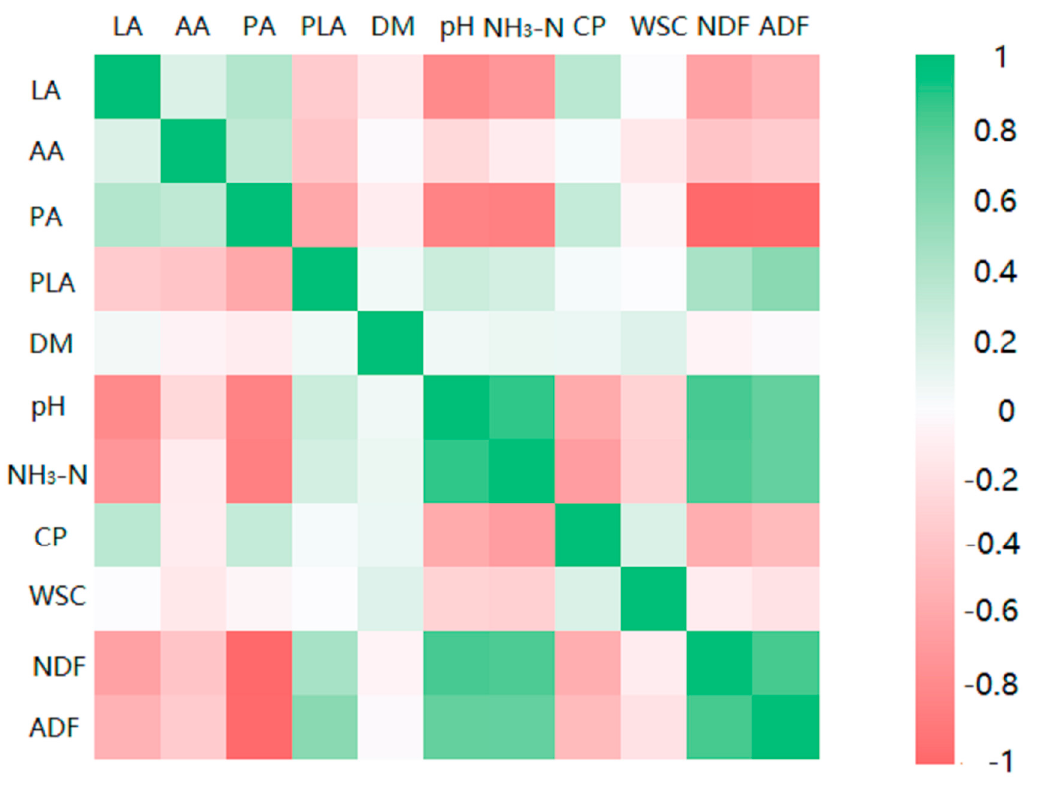
Figure 3. Spearman correlation between the fermentation indices in alfalfa silage after 45 days of ensiling. LA, lactic acid; AA, acetic acid; PA, propionic acid; PLA, phenyllactic acid; DM, dry matter; NH3–N, ammonia nitrogen; CP, crude protein; WSC, water soluble carbonhydrate; NDF, neutral detergent fibre; ADF, acid detergent fibre. The color means the significant correlation ( p < 0.05); the deeper color of the square, the more significant the correlation.